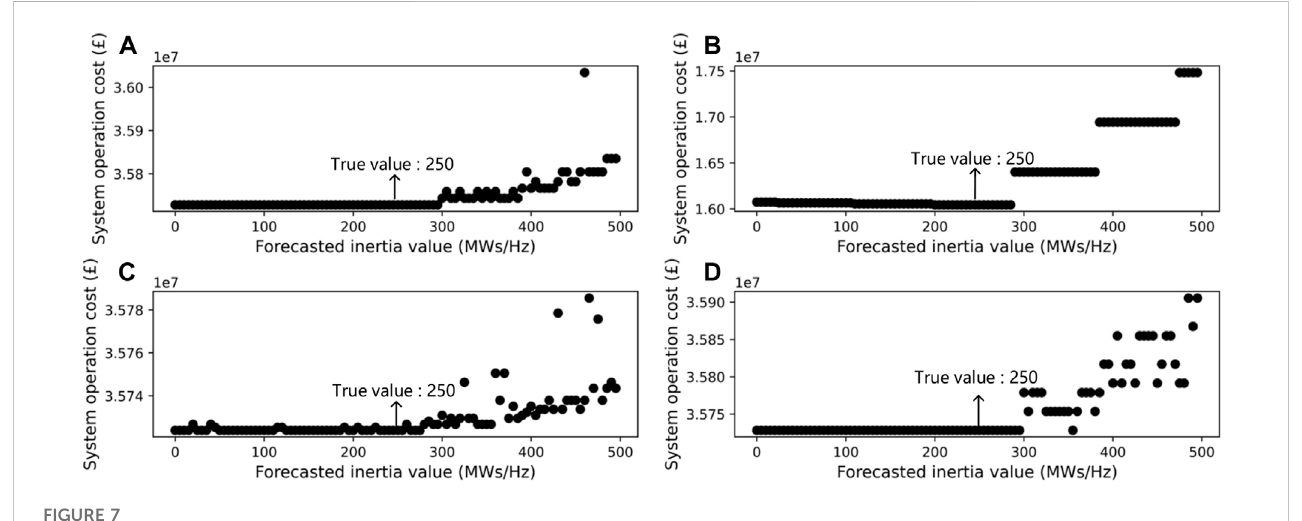
FIGURE 7 Impact of inertia forecasting errors on system operation